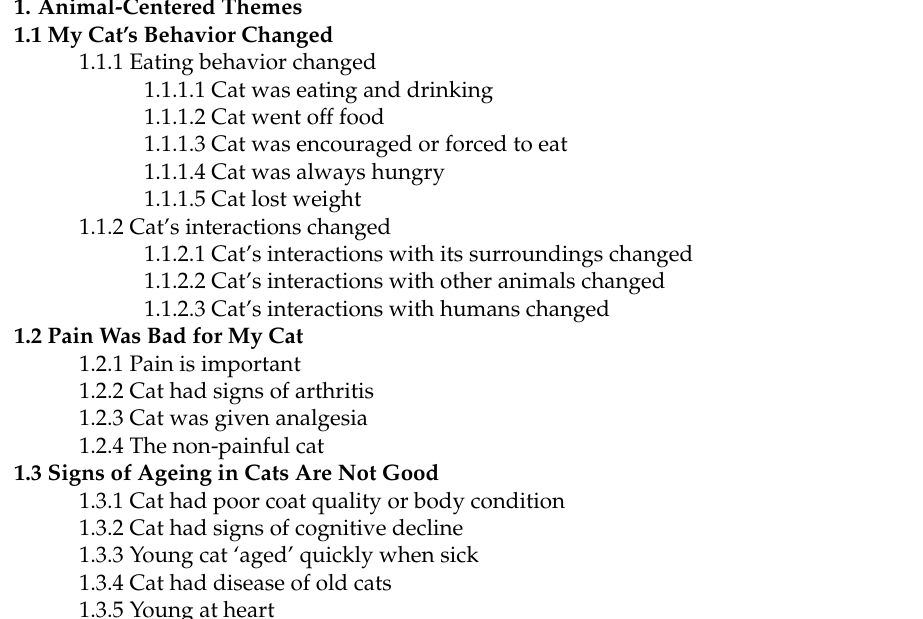
Table 1. Final template for owner interview